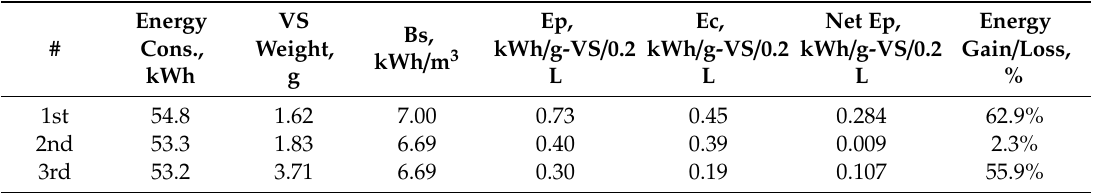
Table 10. The energy balance based on each optimisation